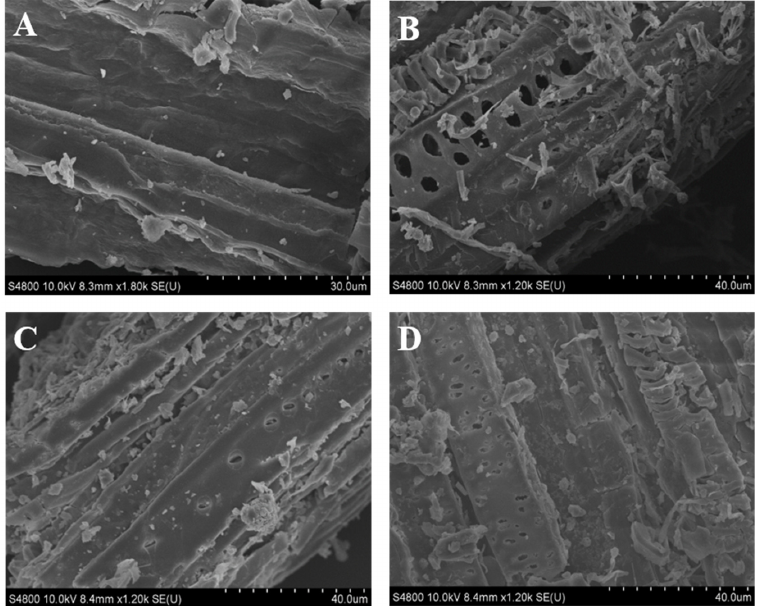
Figure 1. Morphological observation of tea residue. ( A ) Showing surface image of only sterilized control; ( B ) P. chrysosporium treatment group; ( C ) P. ostreatus treatment group; ( D ) dual treatment group.